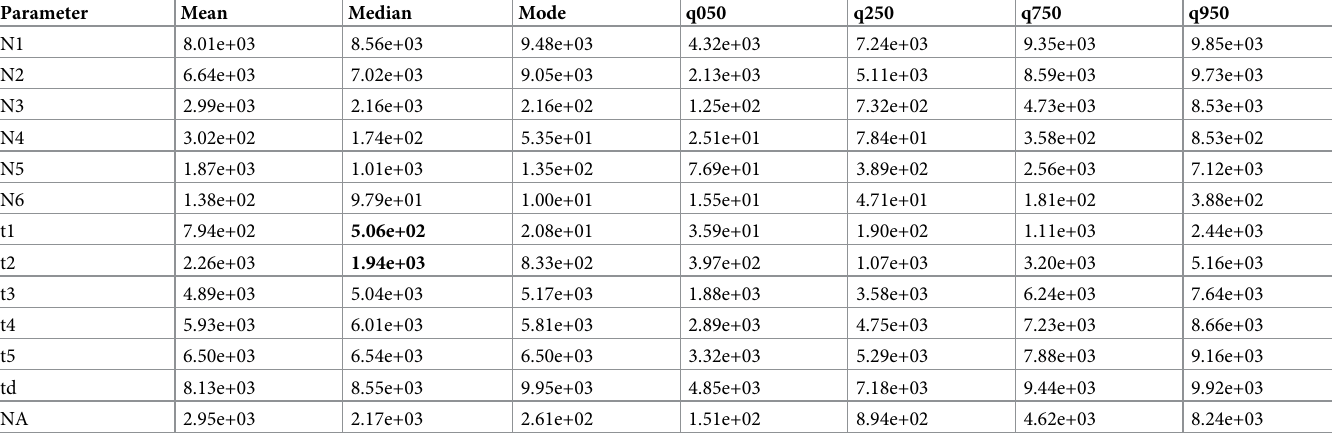
N1-N2-N3-N4-N5-N6 = Cameroon-Ethiopian-Moroccan-Barki-Iranian-Cashmere goat populations effective population sizes; NA = effective population size of the starting population; t1 = time of divergence of Cameroon goats from Moroccan goats in generations (3 years per generation in goats); td = divergence time from the starting population.